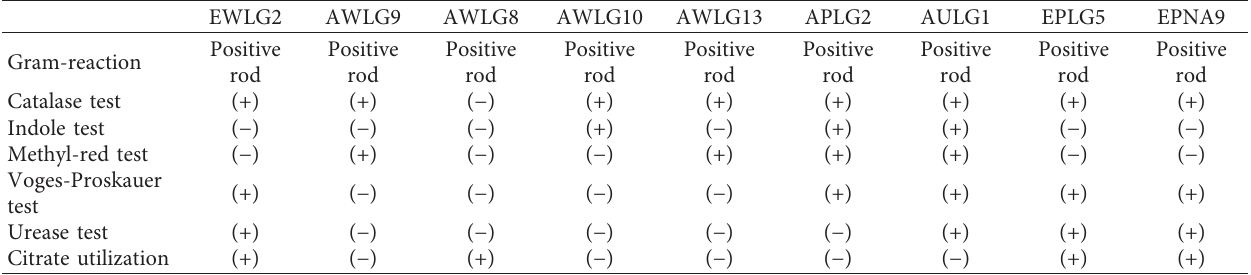
Table 1: Morphological and biochemical phenotypic characterization of isolates with high cellulolytic and antimicrobial activities.